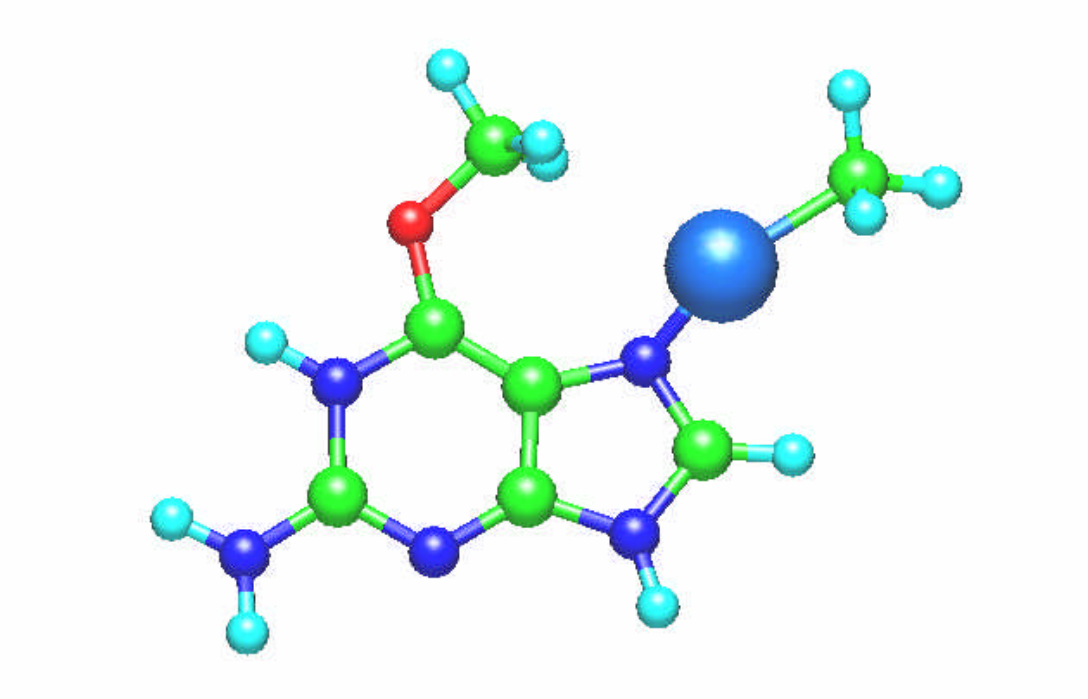
) (guanine)] 2+ complex. One CH 3 2 )] 2+ group to the nitrogen N7 atom in the ring 3